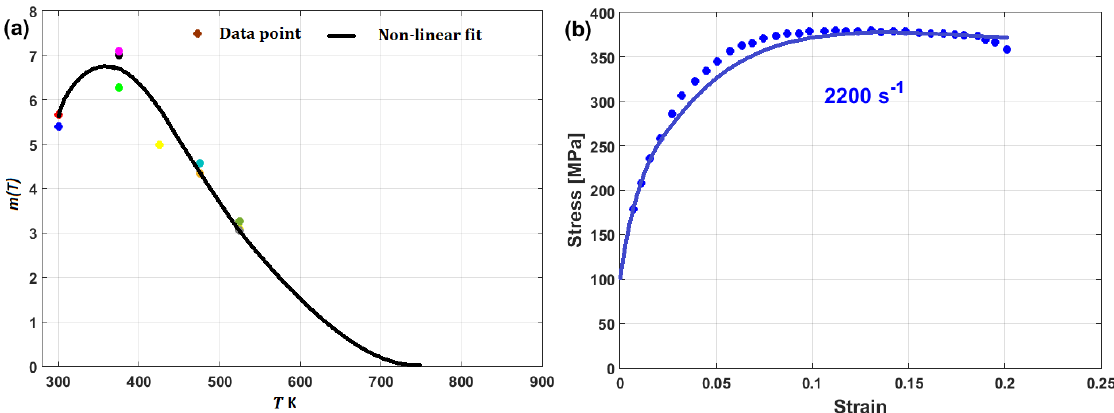
Figure 42. ( a ) Quadratic polynomial of 𝑚(𝑇) and ( b ) comparison between experimental stresses (markers) and predicted stresses (solid line) for AZ31 magnesium alloy obtained by the modified JC model that was introduced by Zhang et al. [89].